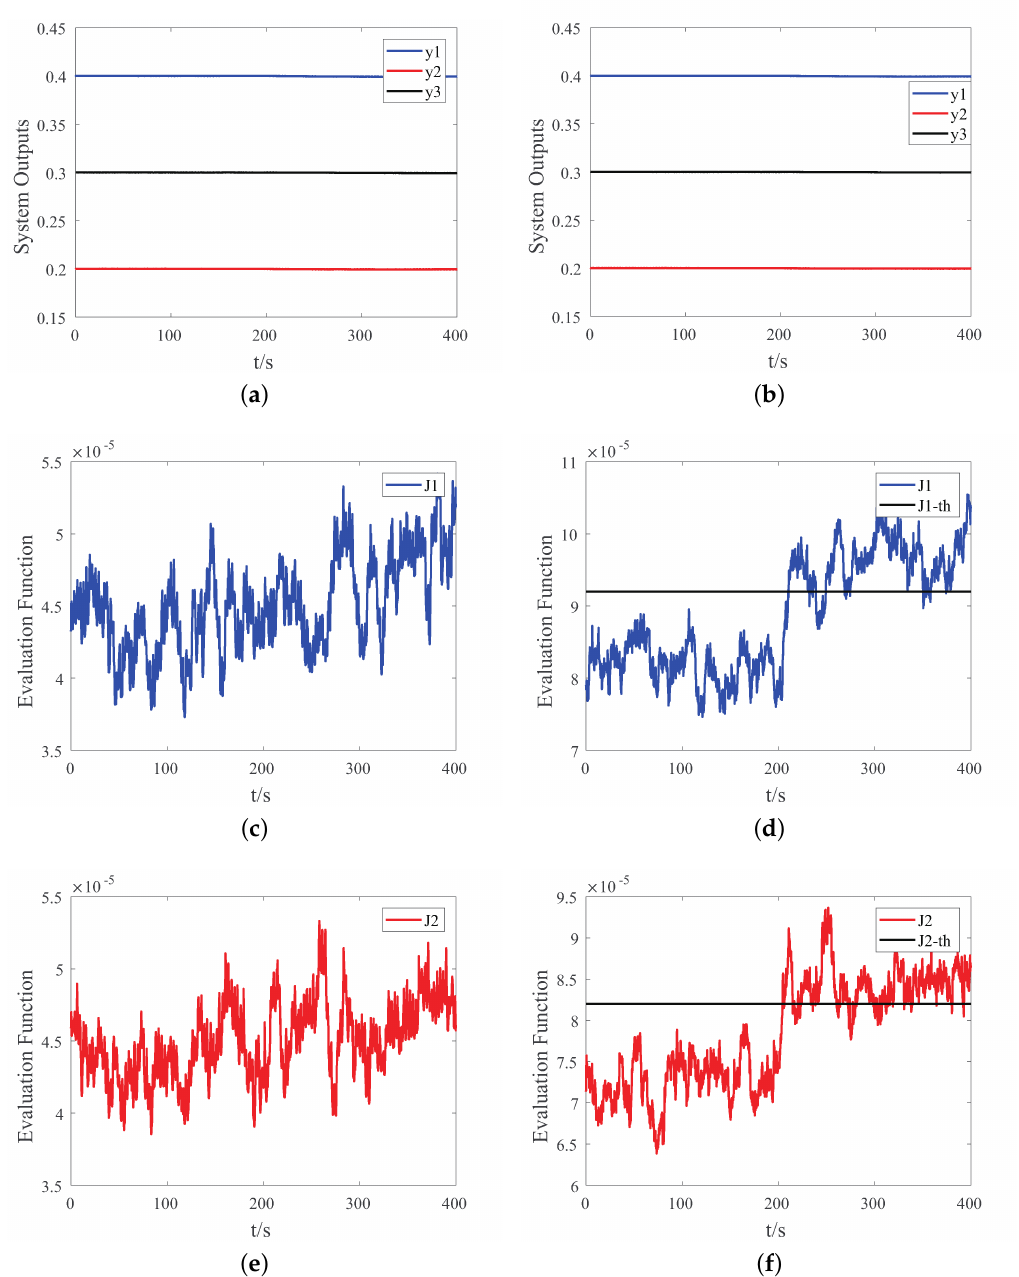
Figure 6. Simulation results of the system with fault modes i = 1 and i = 2 occurring simultaneously at 200 s: ( a ) system outputs without auxiliary signals; ( b ) system outputs with auxiliary signals; ( c ) the evaluation function J [ 1 ] without auxiliary signals; ( d ) the evaluation function J [ 1 ] with auxiliary signals; ( e ) the evaluation function J [ 2 ] without auxiliary signals; ( f ) the evaluation function J [ 2 ] with auxiliary